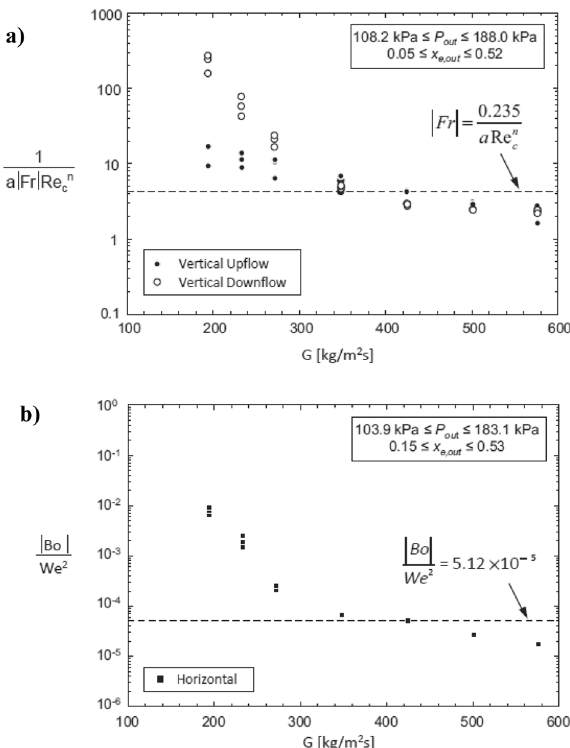
Fig. 7 Mechanistic criteria for gravity-independent condensation heat transfer. Values of the dimensionless group in ( a ) the fi rst criterion and ( b ) the second criterion for gravity-independent condensation heat transfer versus inlet mass velocity, evaluated using the experimental exit conditions (O ’ Neill et al. 40